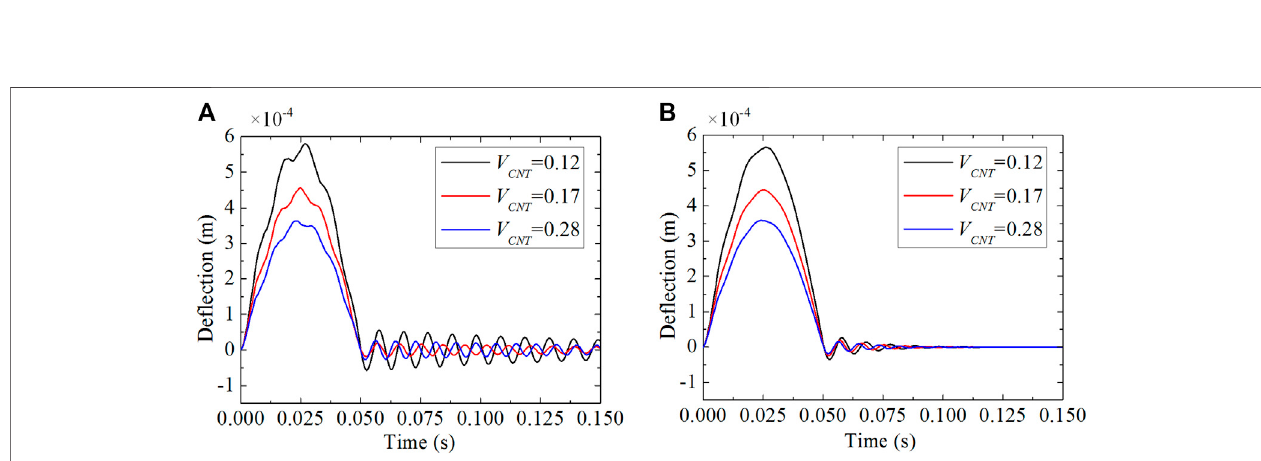
FIGURE9| Centralde fl ectionresponsecontrolunderSSSSboundaryconditionssubjectedtosineexcitationwithdifferentvelocityfeedbackgains: (A) Gv =0.001; (B) Gv = 0.01.